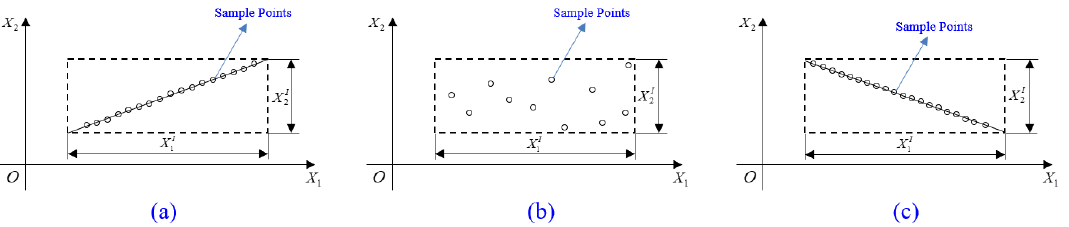
Figure 4. Parallelogram models for three typical correlation coefficients. ( a ) Positive Correlation, ρ 12 = 1; ( b ) Independent, ρ 12 = 0; ( c ) Negative Correlation, ρ 12 = −1. (Figure 4a). When θ ij = 90 ◦ , ρ ij = 0, X i and X j are independent, and the parallelogram model degenerates into an interval model (Figure 4b). When θ ij = π − arctan and X i and X j are linearly negatively correlated (Figure 4c). Figure 3. Three-dimensional parallelepiped model.